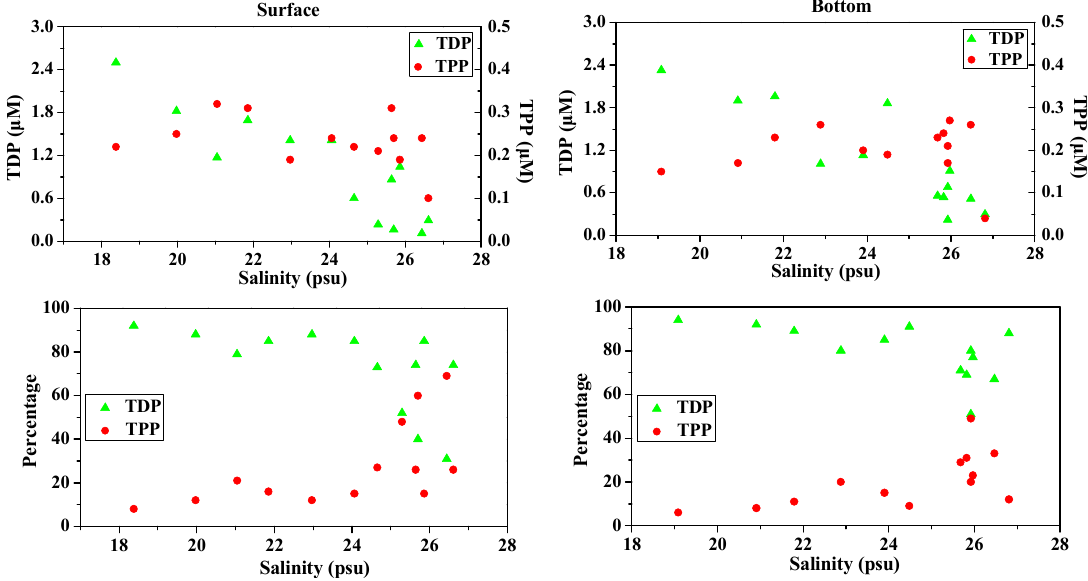
Figure 6. Variations in concentration and percentage of TDP and TPP with salinity in surface water (surface, left panels) and bottom waters (bottom, right panels) of the Dafengjiang River estuary.